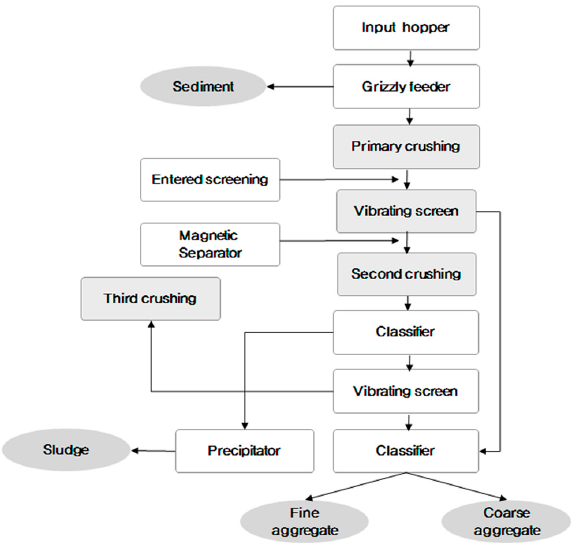
Figure 1. Dry production method.